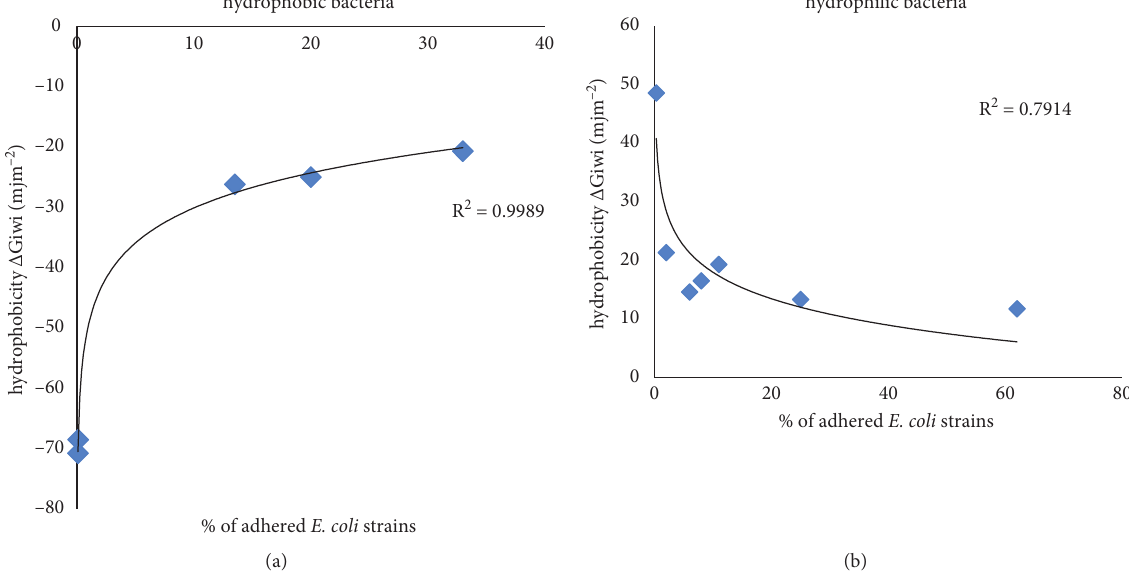
Figure 3: Logarithmic correlation between the bacterial surface hydrophobicity Δ G (a) Hydrophobic bacteria ∆ G iwi < 0. (b) Hydrophilic bacteria ∆ G iwi > 0.